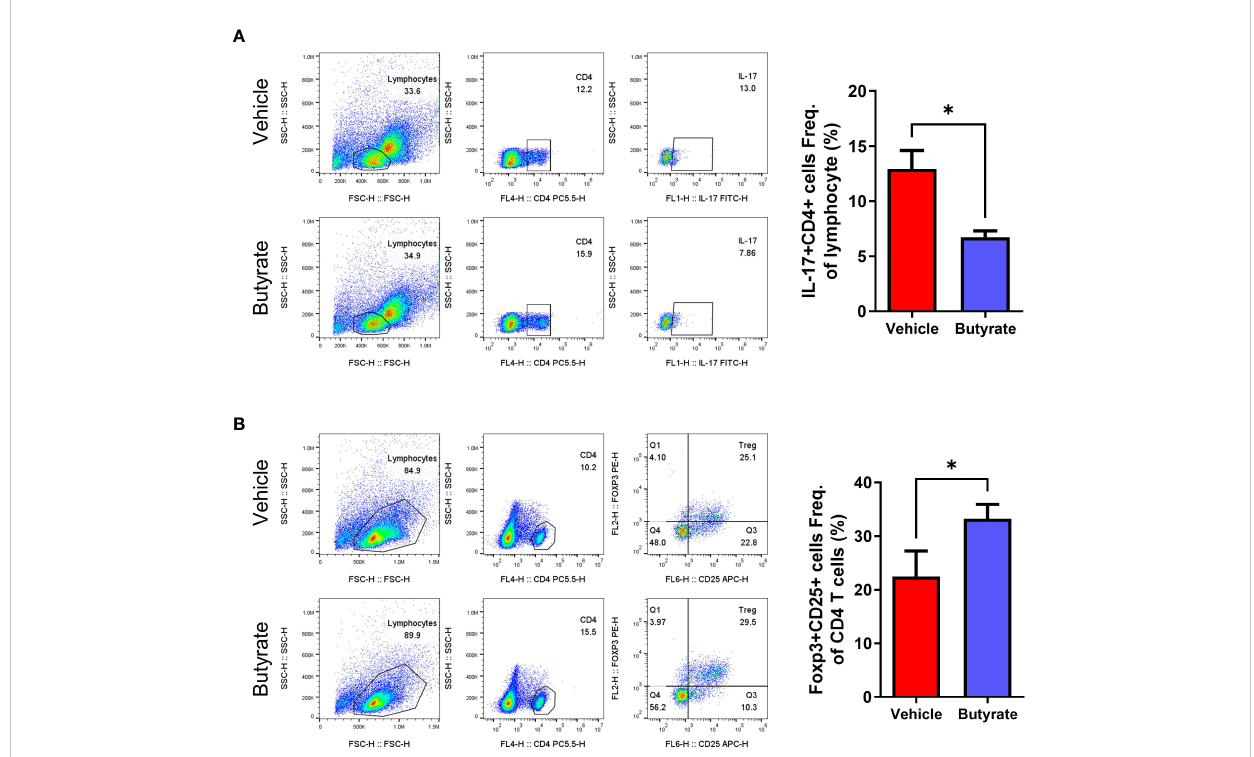
FIGURE 6 Effects of butyrate on the CD4 + T cell differentiation of SpA mice splenocytes ( ex vivo ). At 15 weeks post curdlan injection, (A, B) The expression of Th17 (CD4 + IL-17 + ), and Tregs (CD4 + CD25 + FOXP3 + ) in total CD4 + cells of splenocytes were assessed using fl ow cytometry (presented with representative fl ow cytometry image). * P <